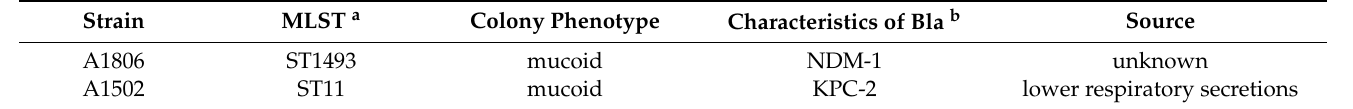
Figure 1. Characteristics of Φ SRD2021. ( A ) Φ SRD2021 infectivity on CRKP A1806 at different MOIs. ( B ) One-step growth curve of Φ SRD2021. ( C ) Thermal stability. Phage suspensions were incubated at 4, 37, 55, and 65 ◦ C for 4 h; ( D ) pH stability. Phage suspensions were treated with different pH buffers at 37 ◦ C for 4 h, respectively. ( E ) Phage morphology of Φ SRD2021 visualized by TEM. The data represent the mean ± standard deviation from triplicate experiments. Table 1. Characteristics of the clinical K47 serotype CRKP A1806 and